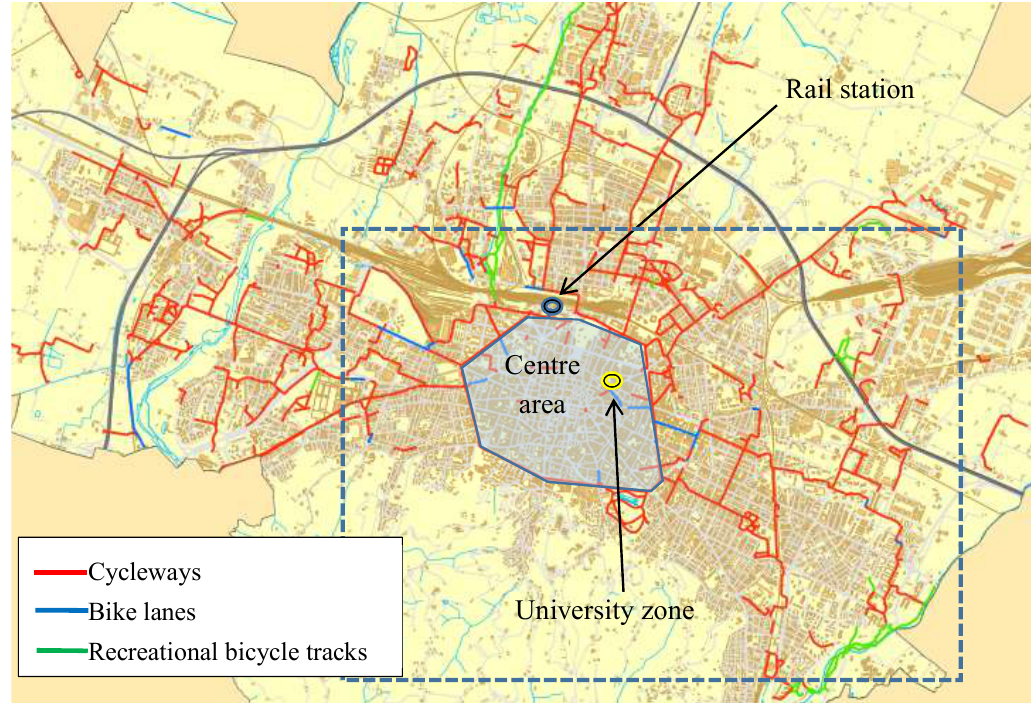
Figure 2. The bike-network map of Bologna [24] and study area (dashed lines).